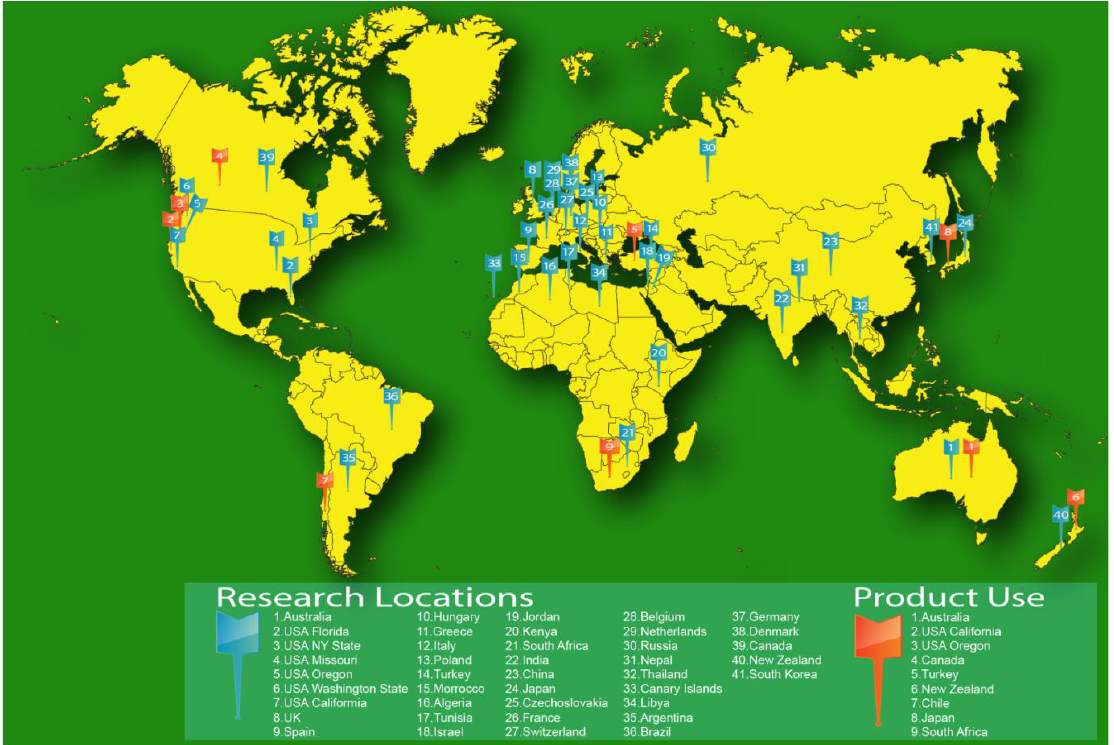
Figure 4. Product distribution and research locations for K84 or K1026.